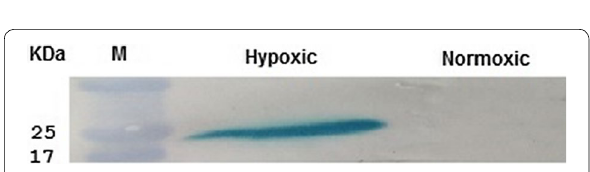
Fig. 2 Western blot analysis of VNP‑Laz cell pellets probed onto an immunoblot with anti‑Lip/H.8 mAb 2C3